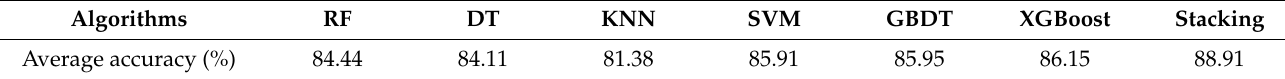
Table 7. Comparison of the accuracy of different